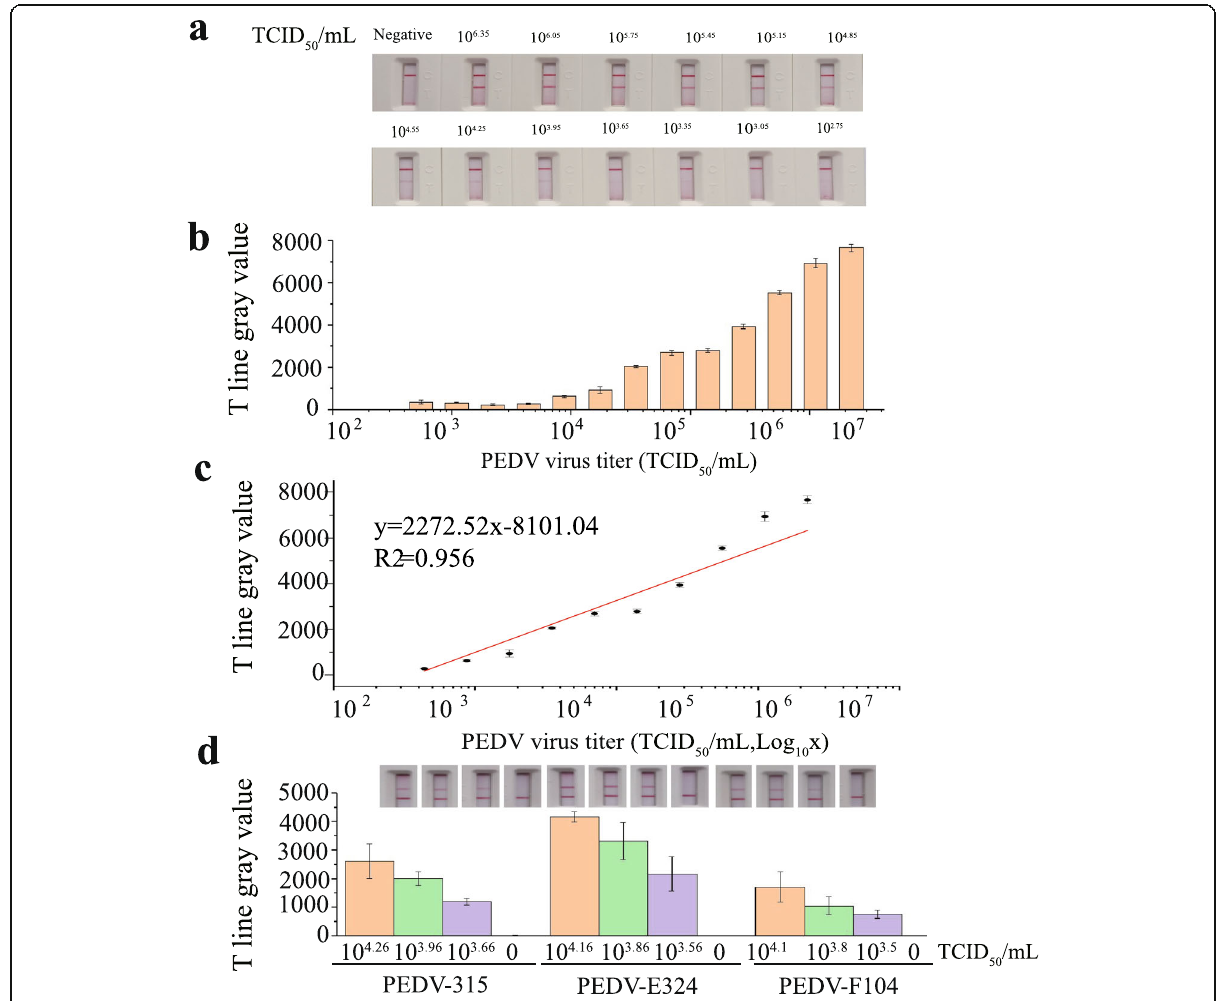
Fig. 4 Analytical sensitivity of LBs-LFIA for PEDV detection a Photograph of visual interpretation b The dependence of the gray value of T line of LBs-LFIA on the concentration of PEDV c A calibration curve drawn of T line gray values in the range of 10 3.65 to 10 6.35 TCID 50 /mL d The LOD verification test for LBs-LFIA. PEDV, porcine epidemic diarrhea virus. Error bars represent the standard deviation of three replicate